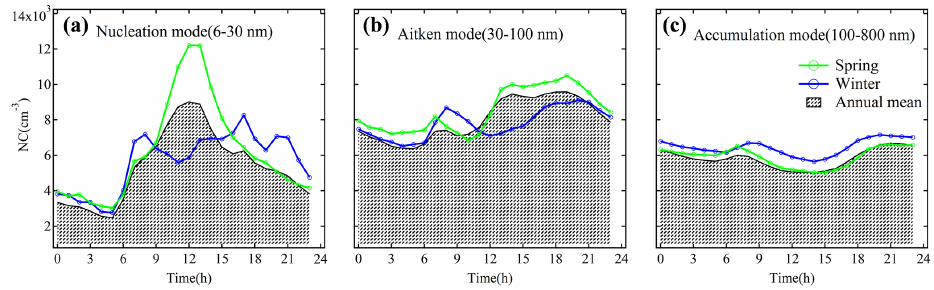
Figure 5. Averaged diurnal variations of particle number concentrations in (a) nucleation mode, (b) Aitken mode and (c) accumulation mode in spring, winter and the entire period during the 2-year measurement period.